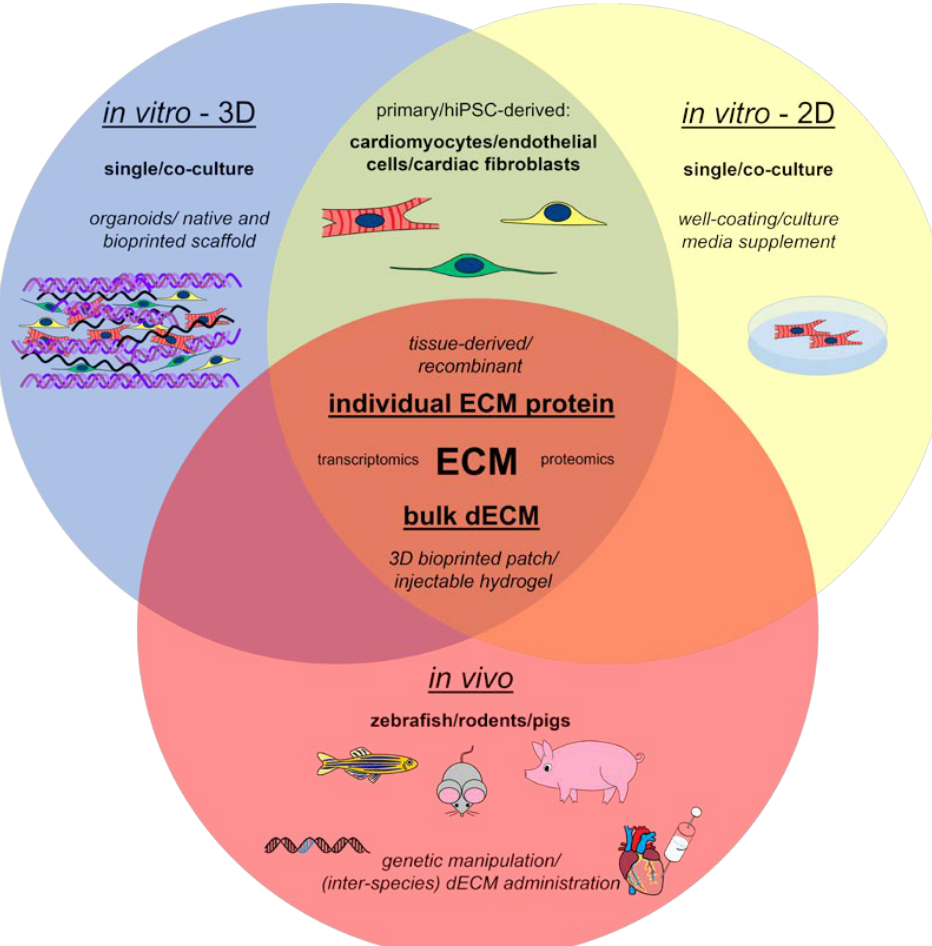
Figure 1. Overview of the main approaches exploited to investigate the role of ECM in cardiac re- Figure generation.